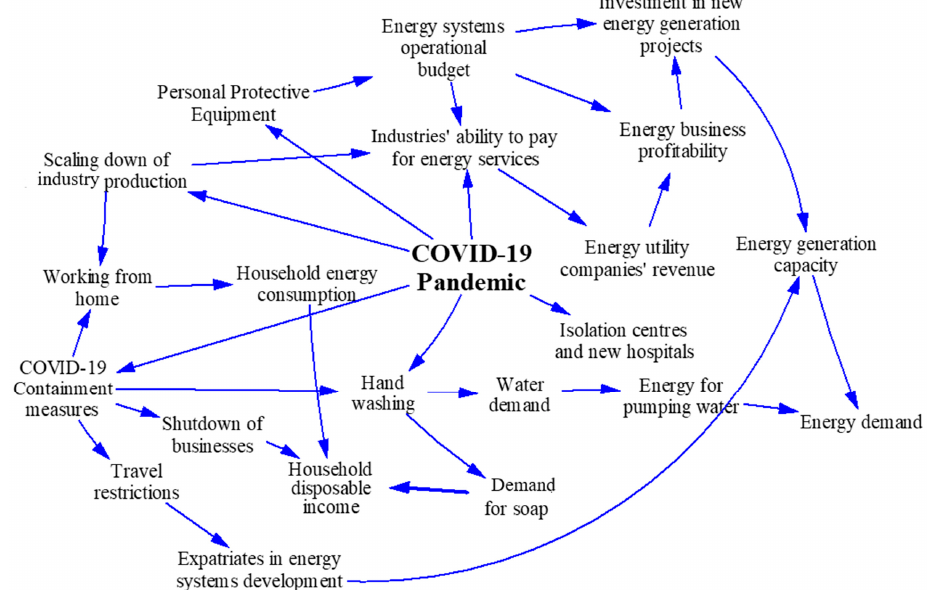
Figure 1. Cognitive map of energy sector variables in Malawi as a result of the COVID-19 pandemic.